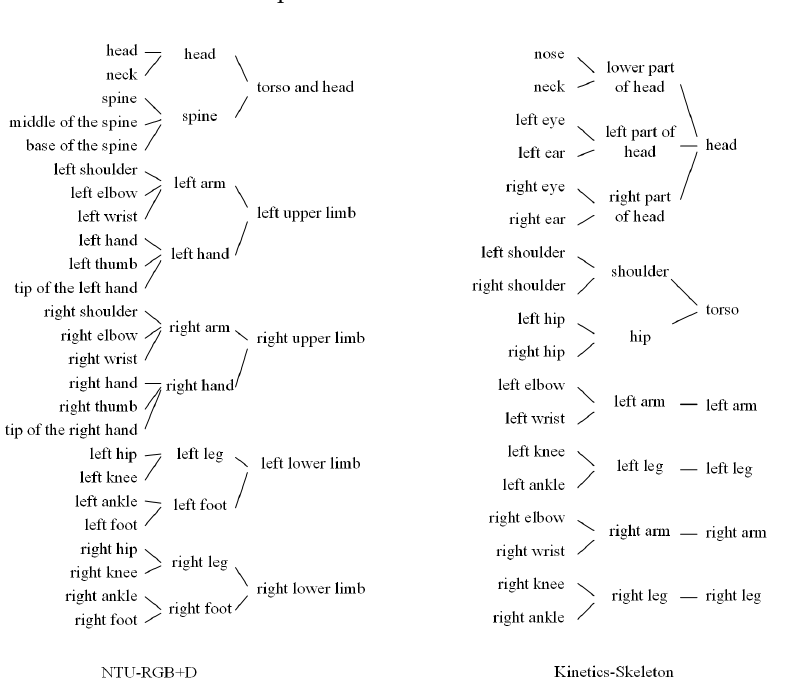
Figure 3. The illustration of the partition strategies for the human skeleton graph of NTU-RGB+D and